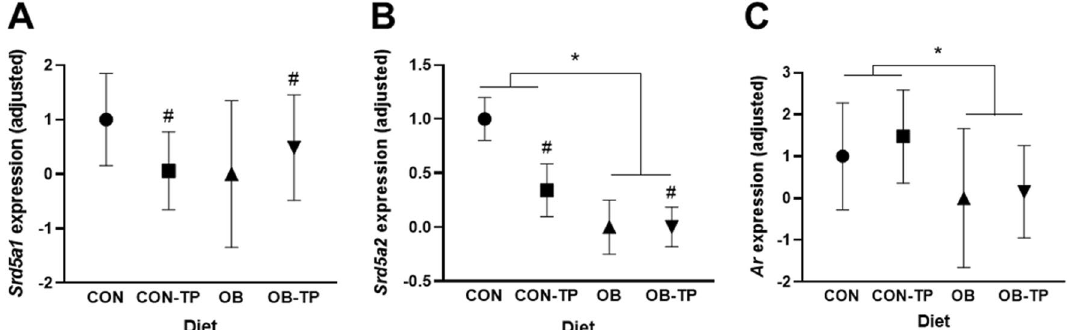
Figure 6. Changes in gene expression of ( A ) srd5a1 , ( B ) srd5a2 , and ( C ) ar by dietary group, after adjusting for body weight at tumor detection. *Indicates statistical significance ( p < 0.05) and # indicates a